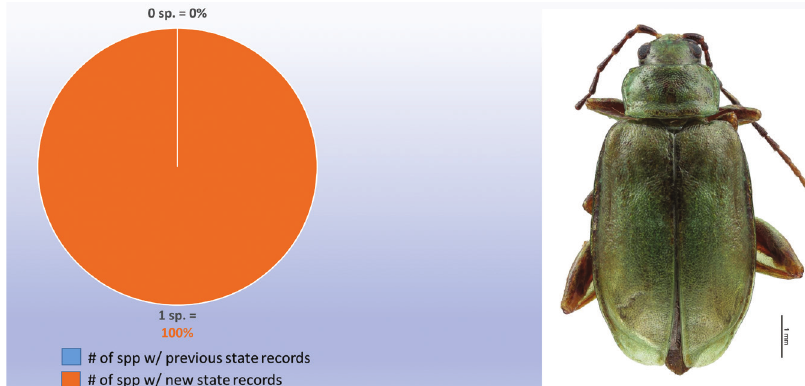
Figure 7. Prasona Baly new state records versus previously recorded state records.